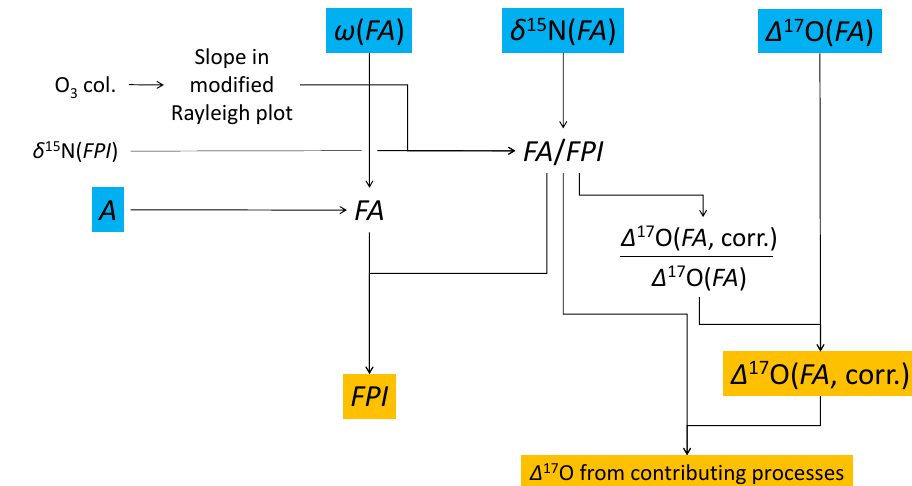
Figure 11. Schematic of the suggested method to retrieve information about the variables in the orange boxes using the measurement of ω (FA), δ 15 N(FA), (cid:49) 17 O(FA) and the annual snow accumulation rates accessible in ice